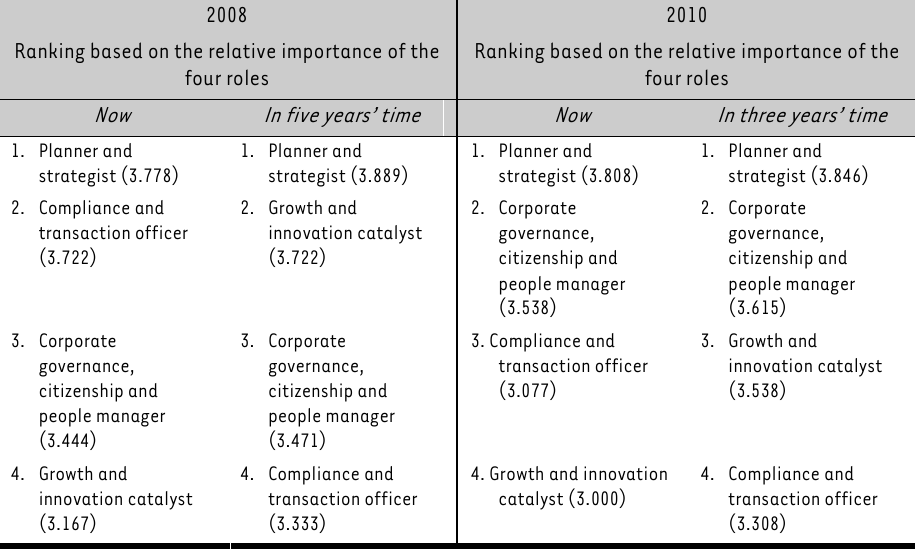
TABLE 16: Comparison of the relative importance of roles now and in the future